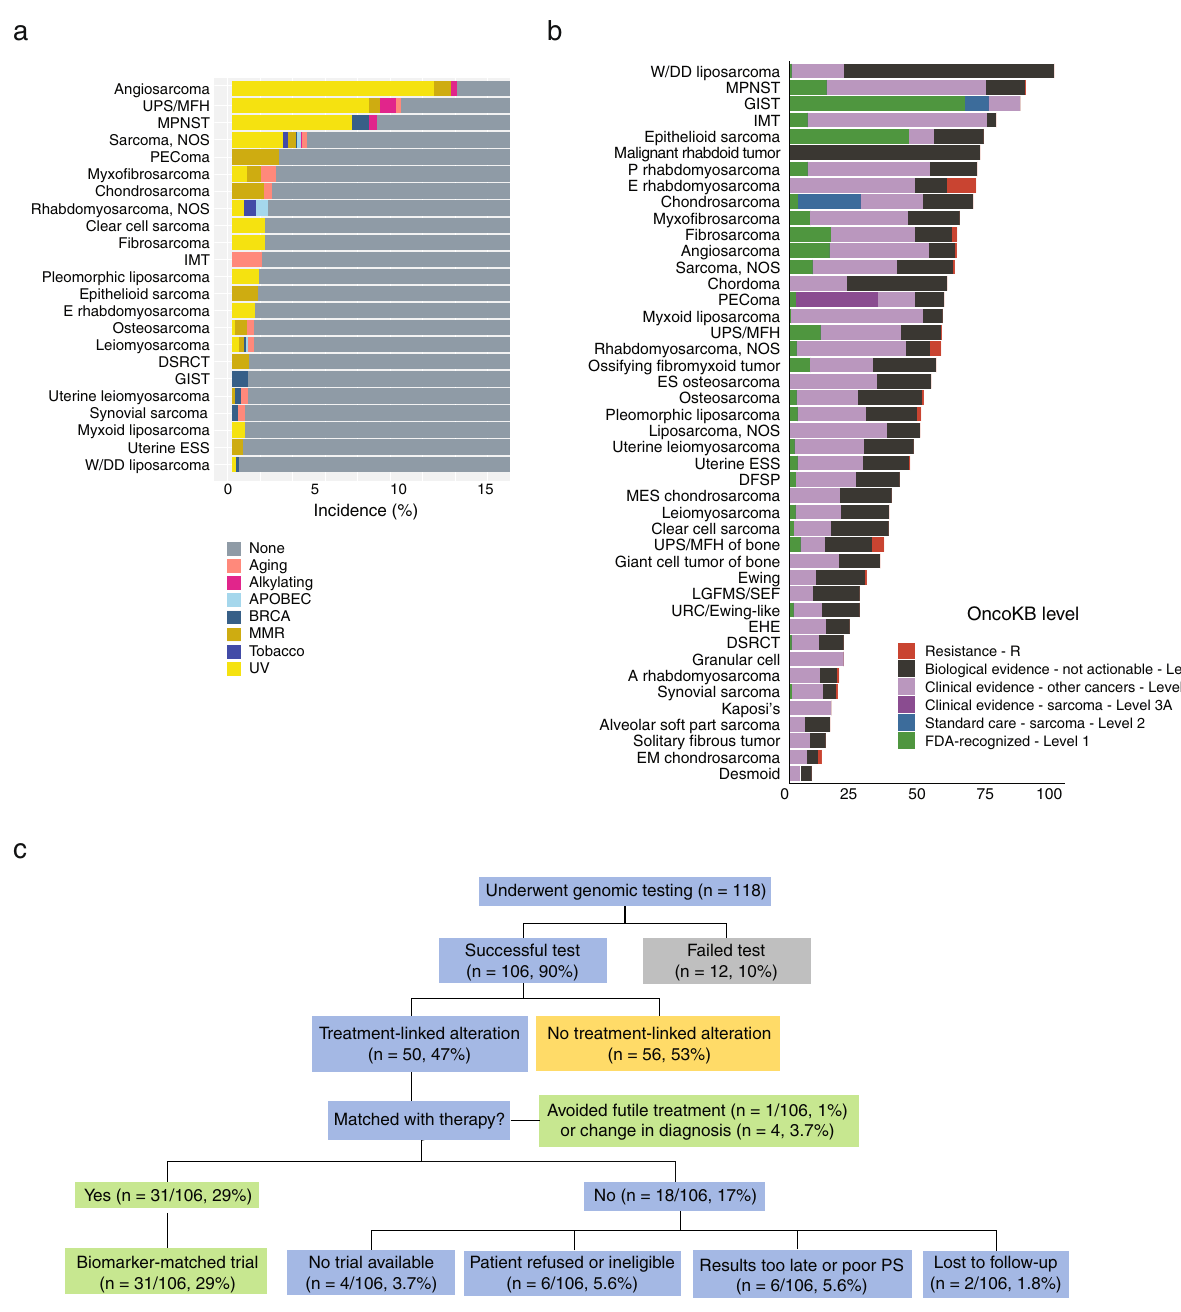
Fig. 5 Actionability. a Dominant mutational signatures in various sarcoma histologies. b Evidence for clinical actionability of somatic alterations across 44 sarcoma histologies. SOC, standard of care. c Flow chart of actions taken as a result of comprehensive genomic sequencing in 118 patients at MSK who underwent Foundation Medicine sequencing. OncoKB classi fi cations were not applied retrospectively for the MSK cohort and thus re fl ect prevailing knowledge at time of enrollment. APOBEC, apolipoprotein B mRNA editing catalytic polypeptide-like; MMR, mismatch repair de fi ciency. Tobacco signi fi es mutational genomic signature attributable to cancers derived from tissues potentially exposed to tobacco smoke. UPS undifferentiated pleomorphic sarcoma, MFH malignant fi brous histiocytoma, MPNST malignant peripheral nerve sheath tumor, NOS not otherwise speci fi ed, PEComa perivascular epithelioid cell tumor, IMT in fl ammatory myo fi broblastic tumor, E embryonal, DSRCT desmoplastic small round cell tumor, GIST gastrointestinal stromal tumor, ESS endometrial stromal sarcoma, W/DD well or dedifferentiated, P pleomorphic, ES extraskeletal, DFSP dermato fi brosarcoma protuberans, MES mesenchymal, LGFMS/SEF low-grade fi bromyxoid sarcoma/sclerosing epithelioid fi brosarcoma, URC undifferentiated round cell, EHE epithelioid hemangioendothelioma, A alveolar, EM extraskeletal myxoid. Source data are provided as a Source Data fi malignant potential. For example, CDKN2A homozygous dele- driven by intragenic copy number deletions), as previously tions only explained loss of p16 in 50% of chordoma 78 . Similarly, reported with whole genome/exome sequencing 79 . in epithelioid sarcoma, while loss of INI-1 protein expression is Ongoing trials of checkpoint inhibitors in sarcoma do not near universal, the encoding SMARCB1 gene is inactivated in only involve selection of patients with genomic biomarkers such as 56% of cases in our study (although these may also potentially be CD274 (PD-L1) ampli fi cation or high MSI, TMB, or tumor-